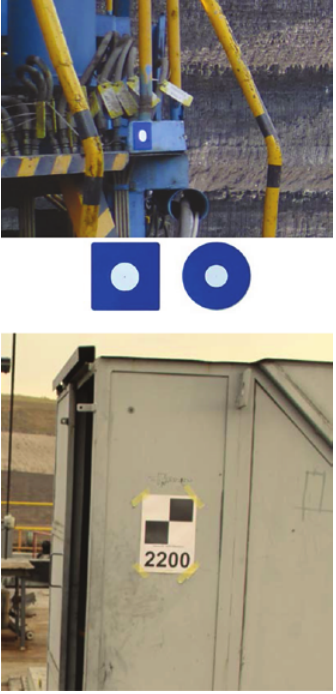
Fig. 4. The point